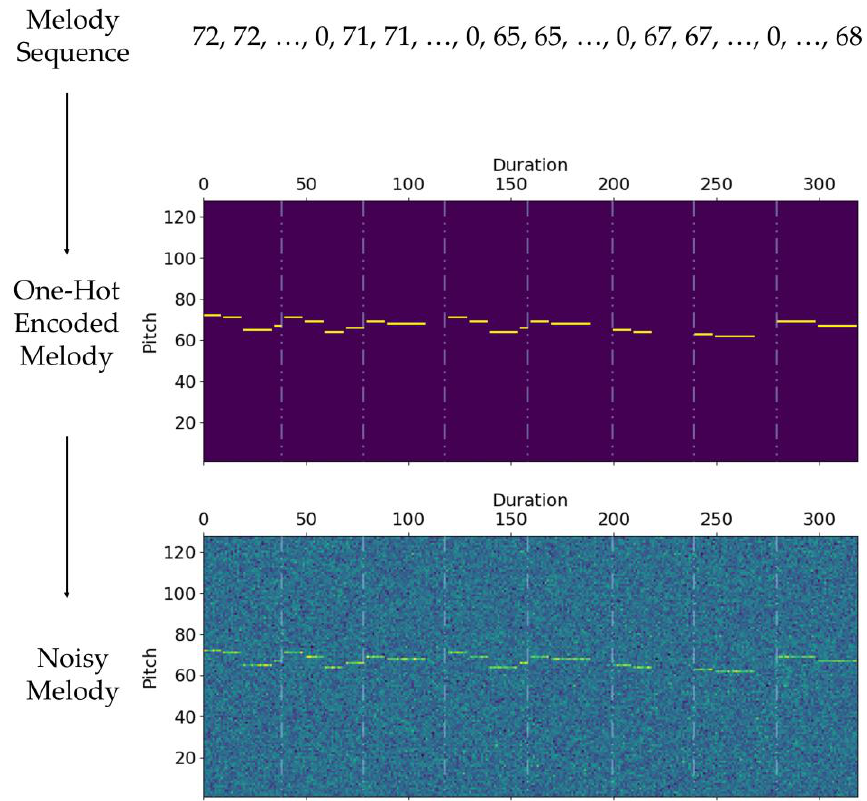
Figure 3. Adding Gaussian noise to the melody sequence.